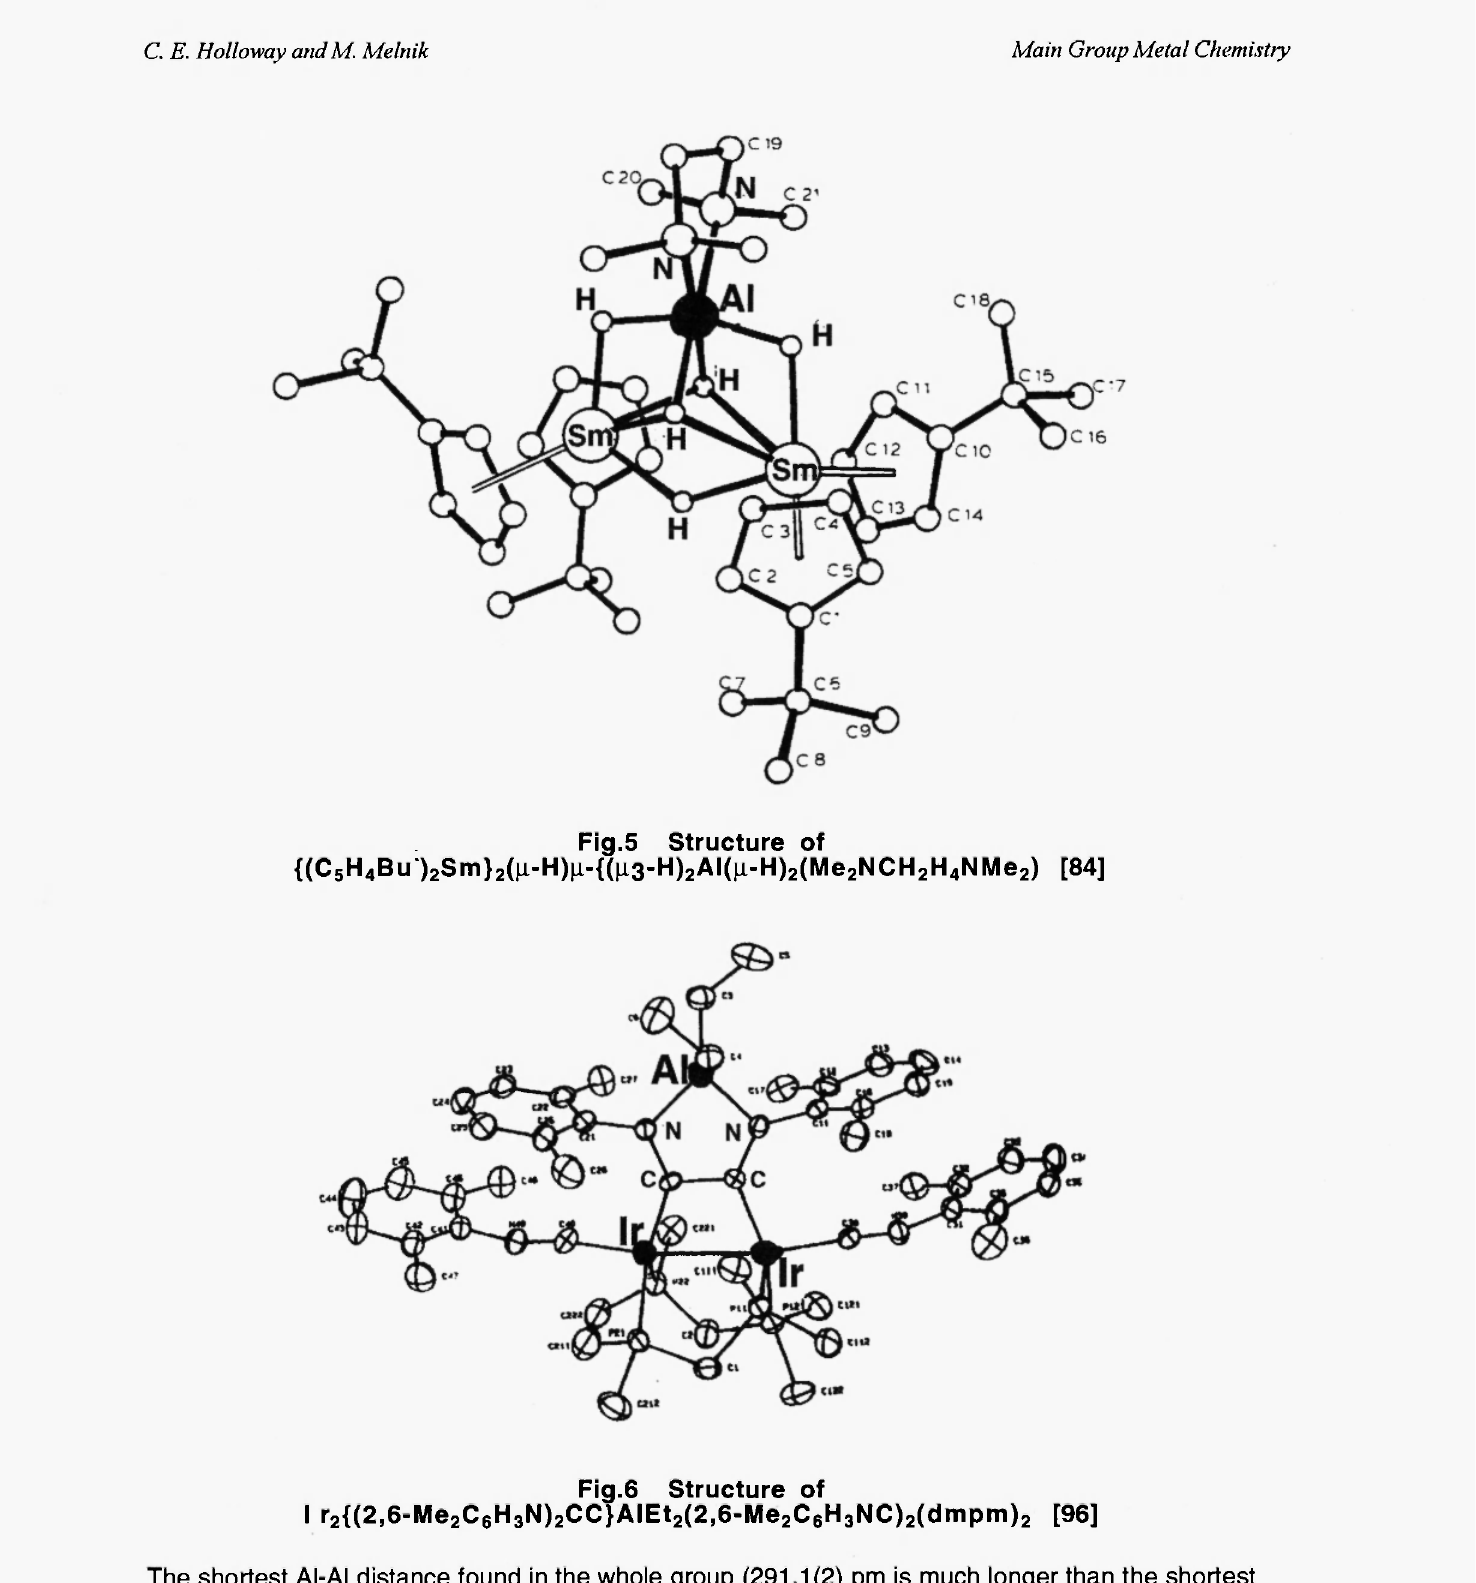
Fig.6 Structure of [96] The shortest AI-AI distance found in the whole group (291.1(2) pm is much longer than the shortest value noted in this present study of heteronuclear aluminium complexes. Overall, however, it would seem that aluminium is usually found bonded with other metal atoms than with itself in these